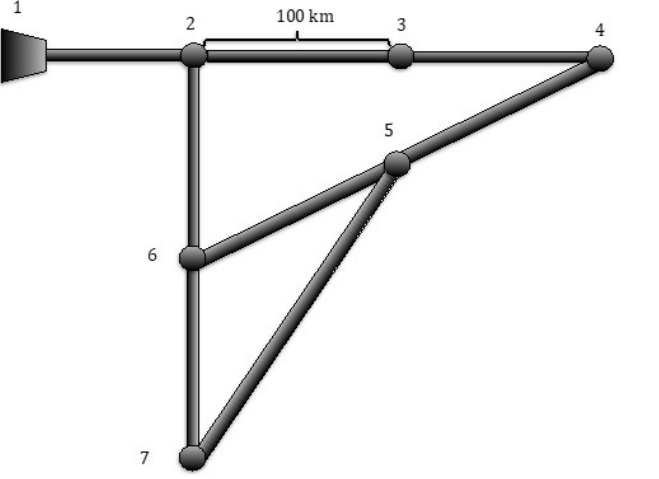
Figure 5. Pipeline network used for calculations.